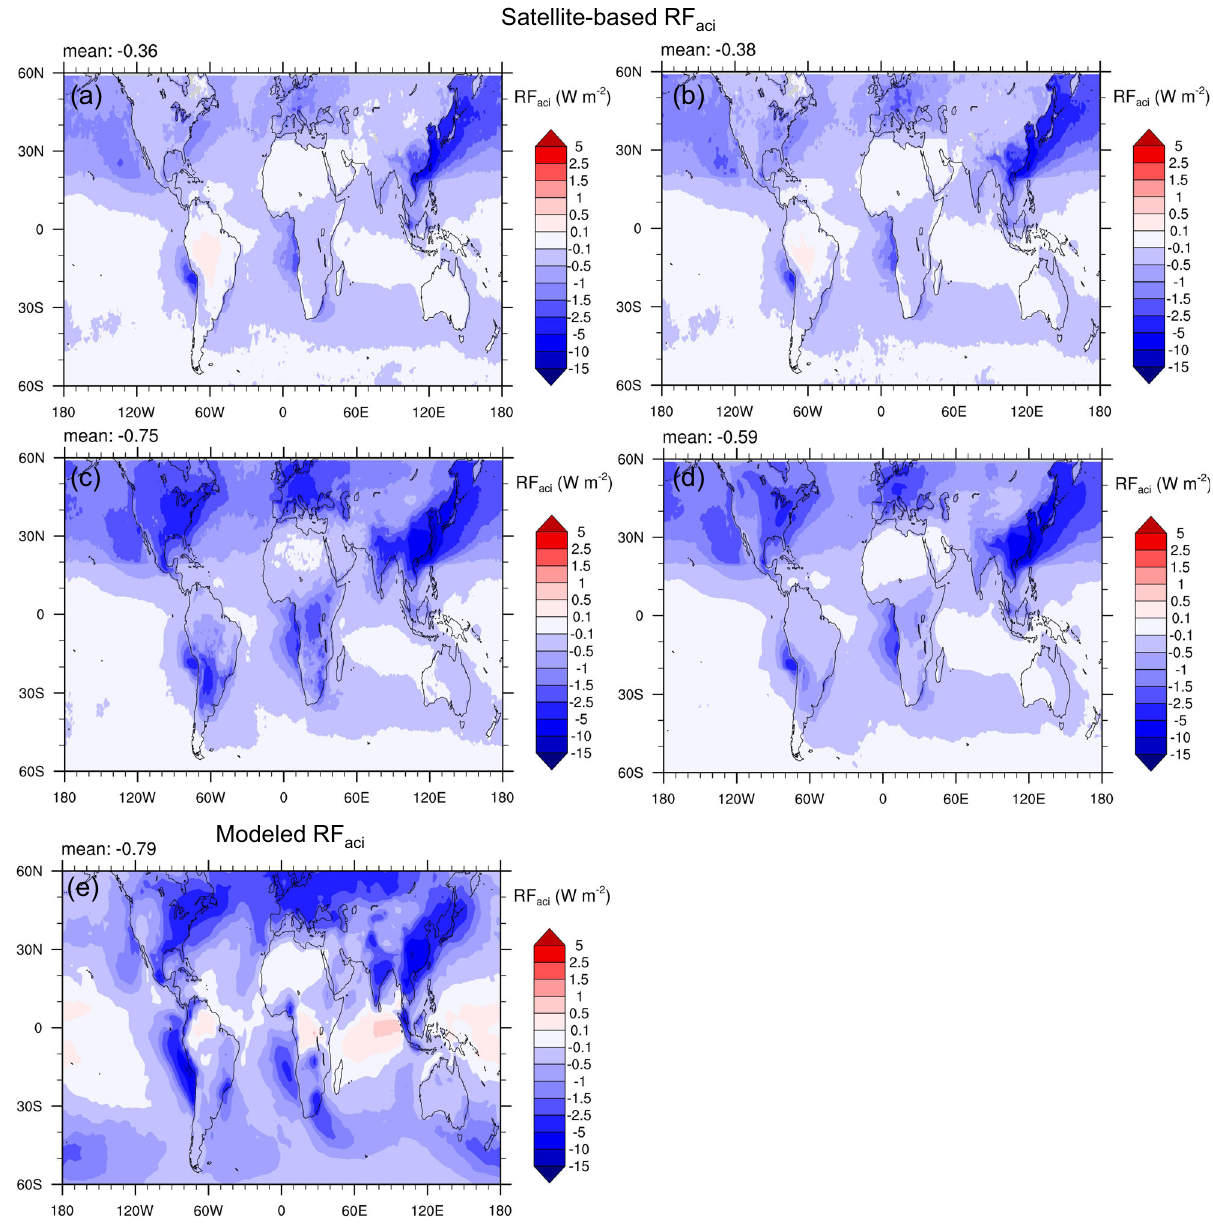
Fig. 4 Annual mean fi rst indirect forcing (RF aci ) at a global scale (60°S to 60°N) for different scenarios. The RF aci calculated from a MODIS-retrieved aerosol optical depth (AOD) and CERES-retrieved cloud droplet number concentration ( N d ) data pairs (Aero_Cld_Modis), and from MERRA-2 re-analyzed AOD and CERES-retrieved N d data pairs for b the scenario that aerosol and cloud retrievals are simultaneously successful (Aero_Cld, including same cloud samples with Aero_Cld_Modis), c the scenario that only cloud retrievals are successful (Cld), and d the scenario including all ambient clouds (All_Cld). e Modeled RF aci from Yu et al. 44 . The respective RF aci values for different regions are also listed in Supplementary Table